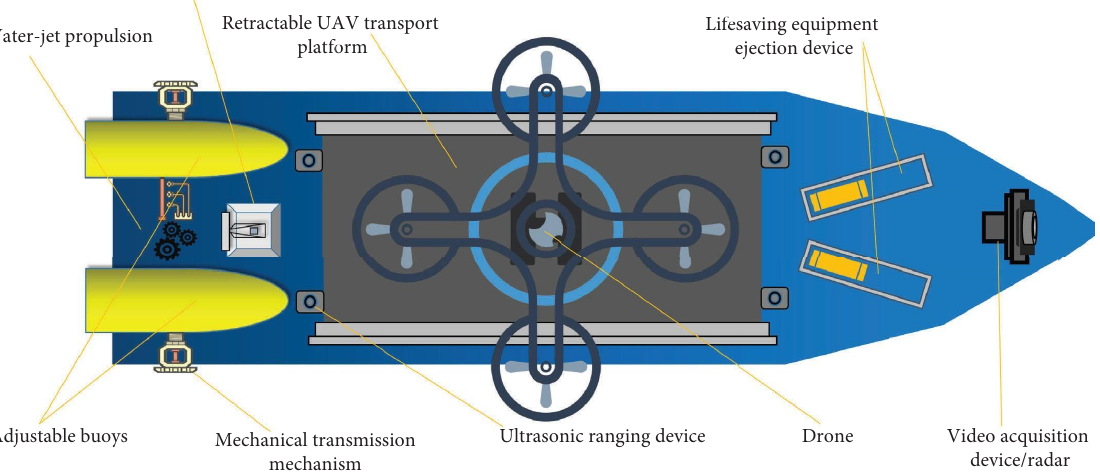
Figure 1: USV-UAV